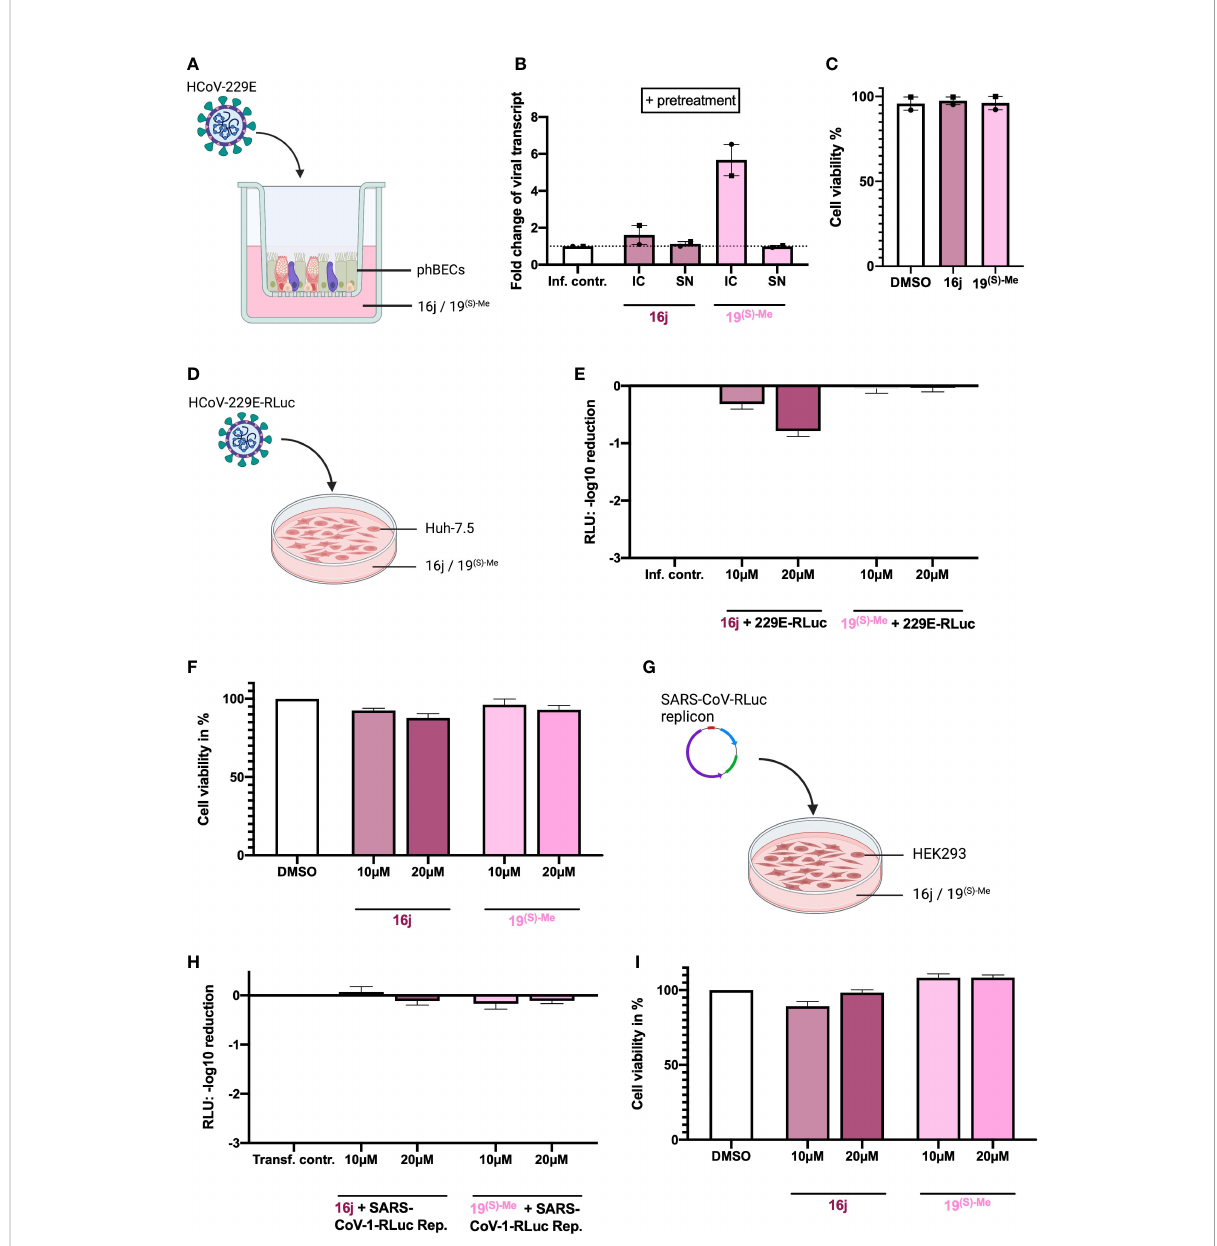
FIGURE 4 Inhibitory effects of non-immunosuppressive FK506 analogs in different human infection models. (A) Illustration of phBEC infection with HCoV- 229E, created with biorender.com. (B) RT-qPCR results of (for 72 h) HCoV-229E infected (MOI = 4) phBECs (n = 2, independent donors) with pretreatment in presence of compounds 16j and 19 (S)-Me (used at 10 µM), given as fold changes of intracellular (IC) and supernatant (SN) viral transcript relative to the infection control (inf. contr.), HCoV-229E-infected phBECs treated with the vehicle DMSO (normalized to 1 for both IC and SN). Intracellular: Normalized to the housekeeping gene DEAH-Box Helicase 8 ( DHX8 ). The symbols each represent an independent donor (circles = donor 1; squares = donor 2). (C) Cell viability as assessed by LDH assay after 48 h pretreatment and 72 h post infection in percent.